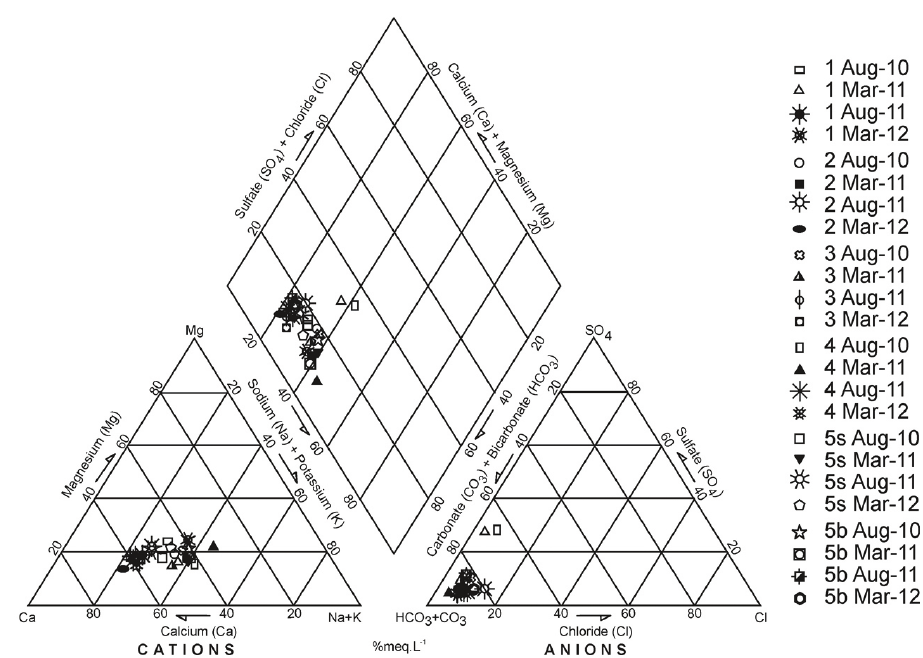
Figure 6. Piper-Hill-Langelier diagrams of the sampling